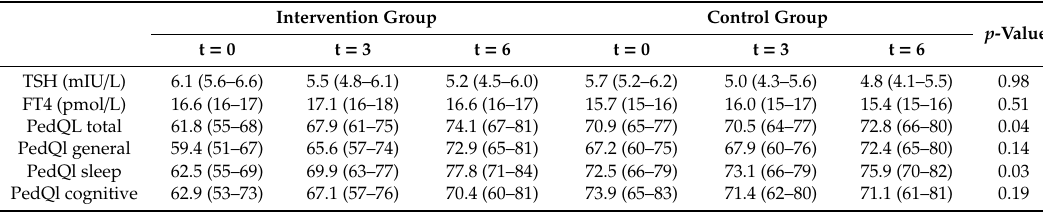
Table 2. Thyroid hormones and fatigue scale (with 95% Confidence Interval) scores during the 6-month intervention (mixed model analysis). p -values express the di ff erences between both